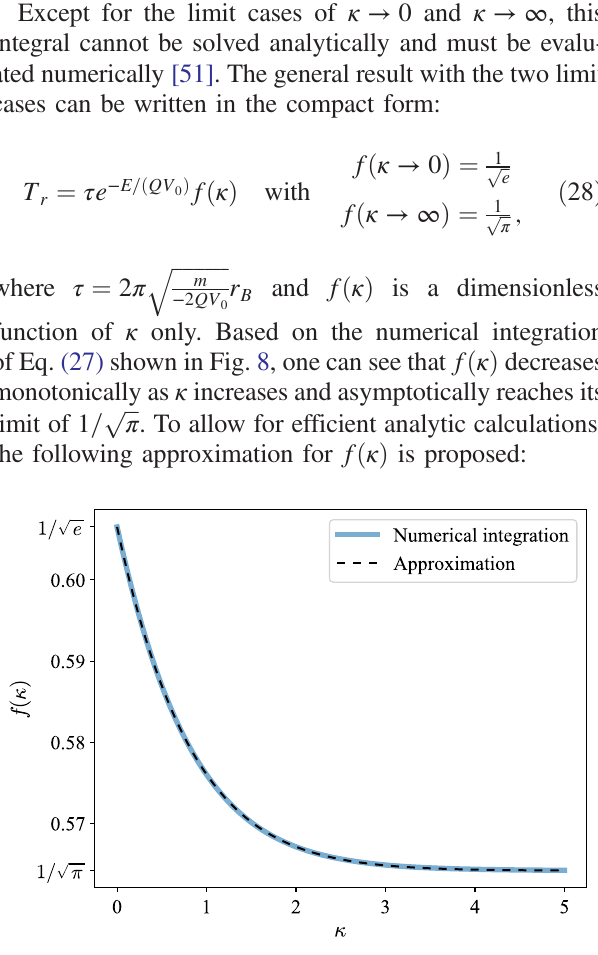
FIG. 8. Comparison of the dimensionless function f ð κ Þ ob- tained from numerical integration and from the approximation Eq. (29). The error from the approximation is below 0.014% for any κ